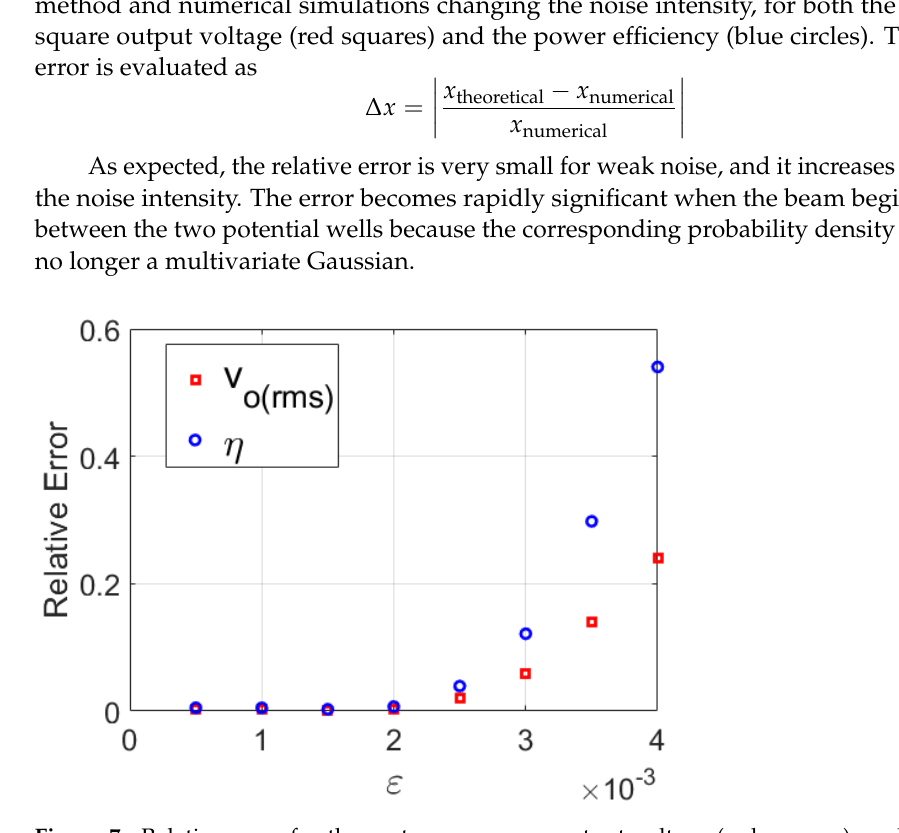
Figure 7. Relative error for the root mean square output voltage (red squares), and the power efficiency (blue circles), between theoretical predictions obtained using Gaussian moment closure method and full numerical simulations versus the noise